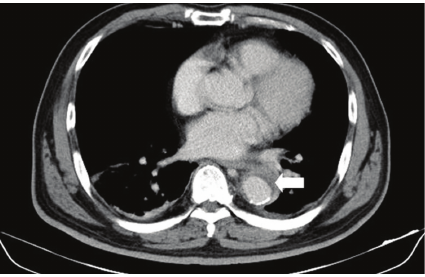
Figure 1: Computed tomography of chest showed aortic intramu- ral hematoma (arrow).